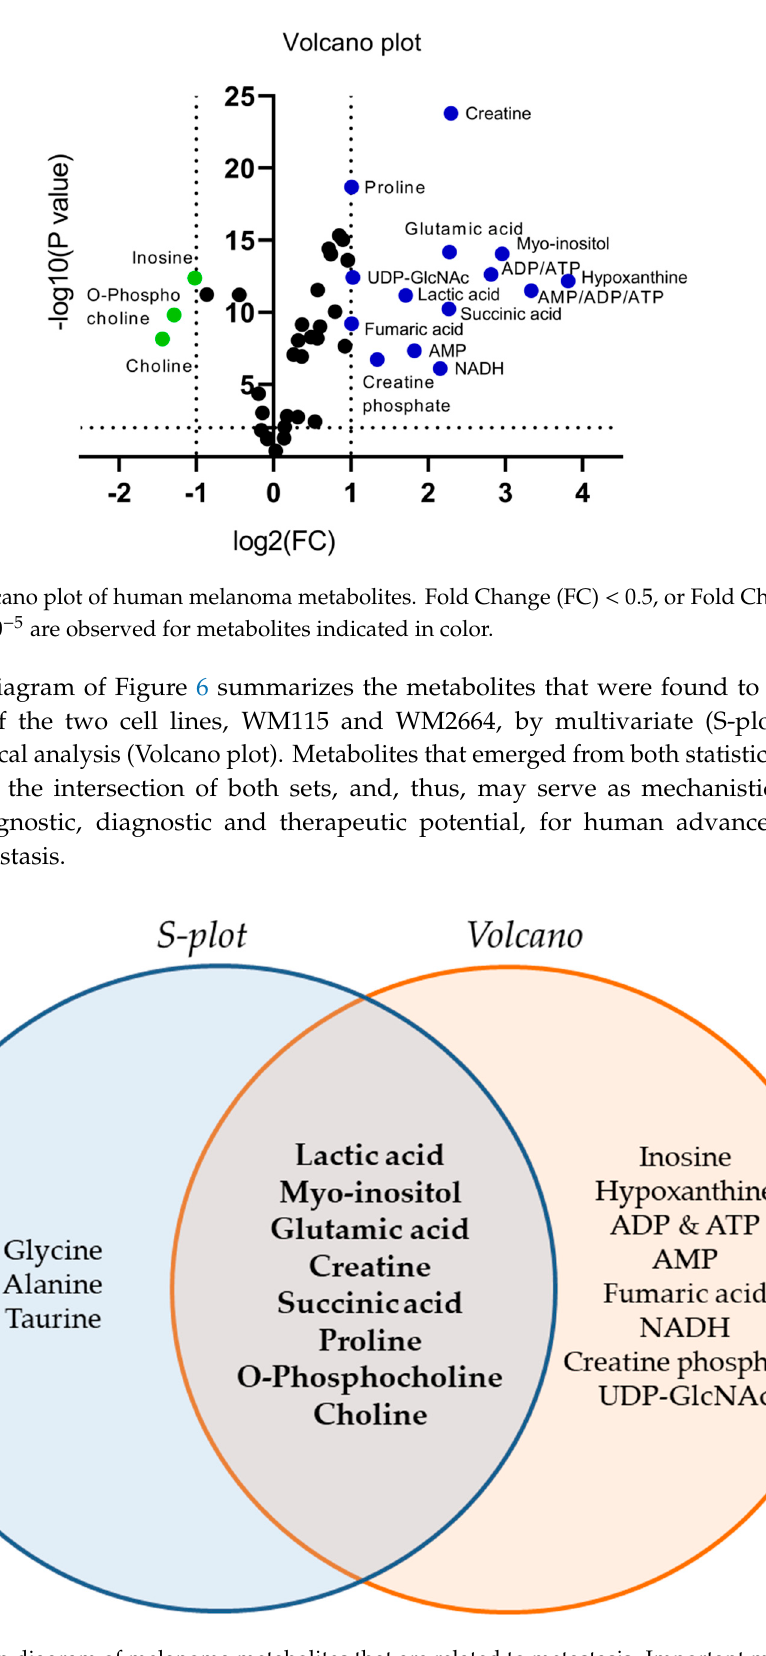
Figure 6. Venn diagram of melanoma metabolites that are related to metastasis. Important metabolites are highlighted (bold fonts) at the interphase of S-plot and Volcano plot.